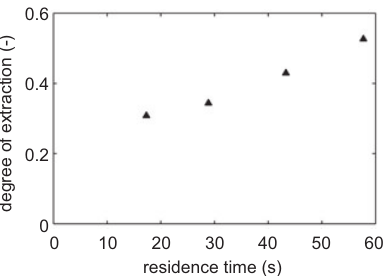
Figure 12 Extraction of the product 2-hydroxy phenylpropanone via a hollow fiber membrane using ethyl acetate for extraction. Mem-brane = 700 μ m, pore diameter parameters: hydrophobic PVDF membrane, d i 0.1 μ m, area 165 mm 2 . Experimental conditions: starting concentration of HPP 20 m m , T = 20 ° C, flow of aqueous phase: 30 – 100 μ